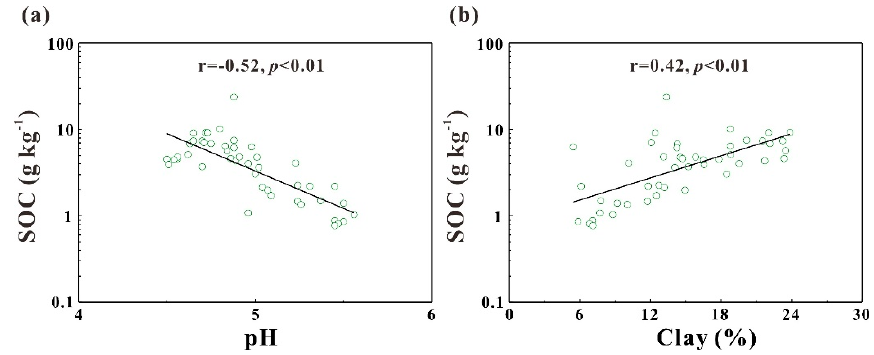
Figure 7. Liner correlation between soil pH ( a ), clay contents ( b ) and SOC